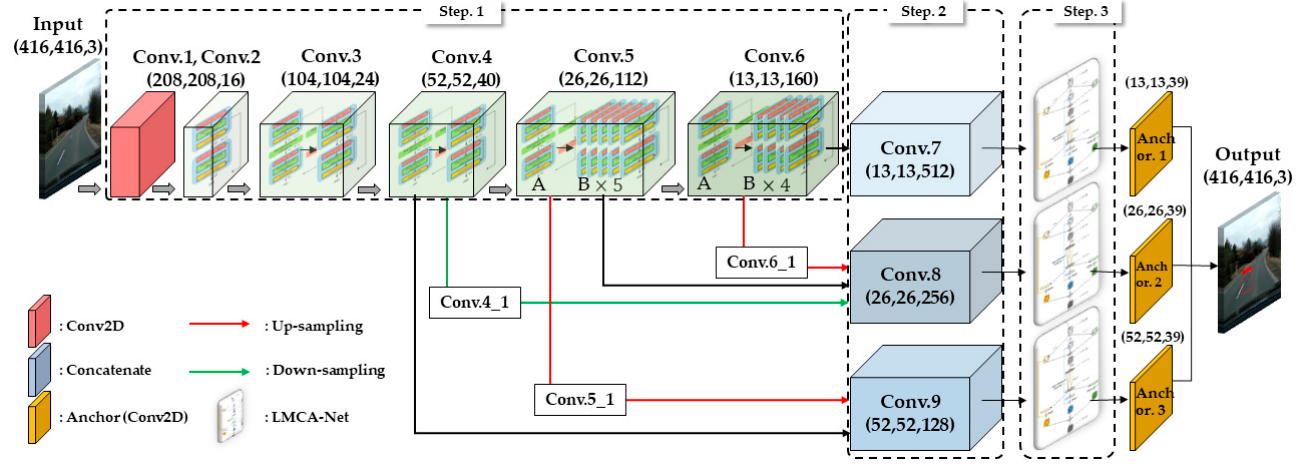
Figure 2. The network framework of the road damage algorithm is proposed in this paper.